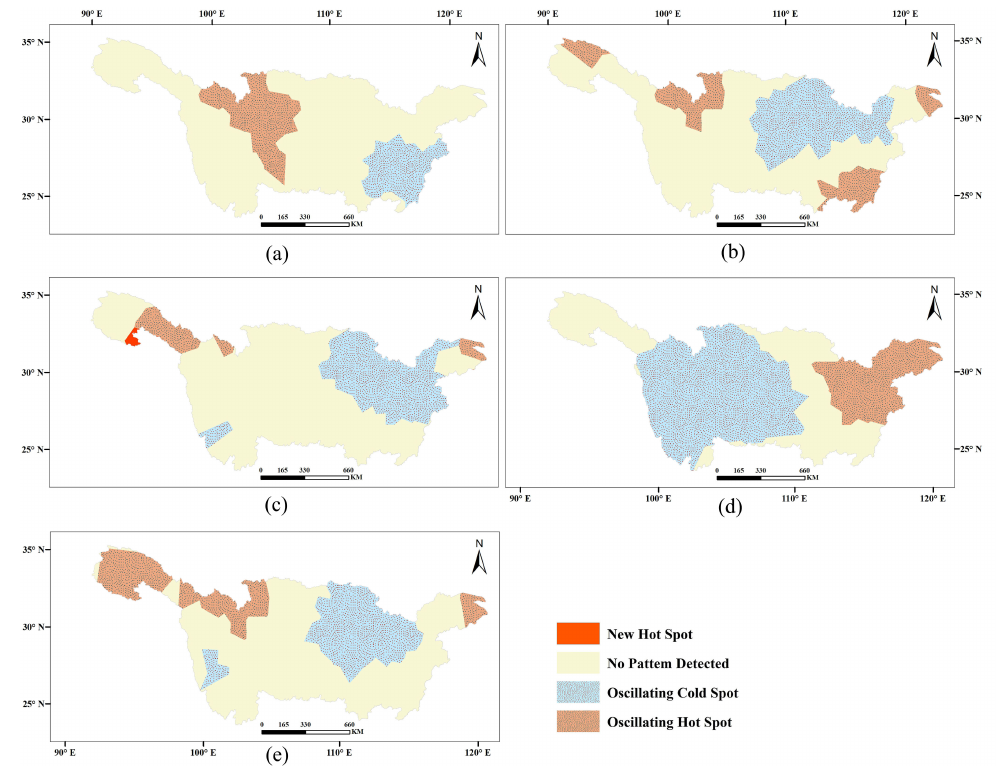
Figure 11. Result of emerging hot spot analysis. ( a ) Spring; ( b ) summer; ( c ) autumn; and ( d ) winter; ( e )